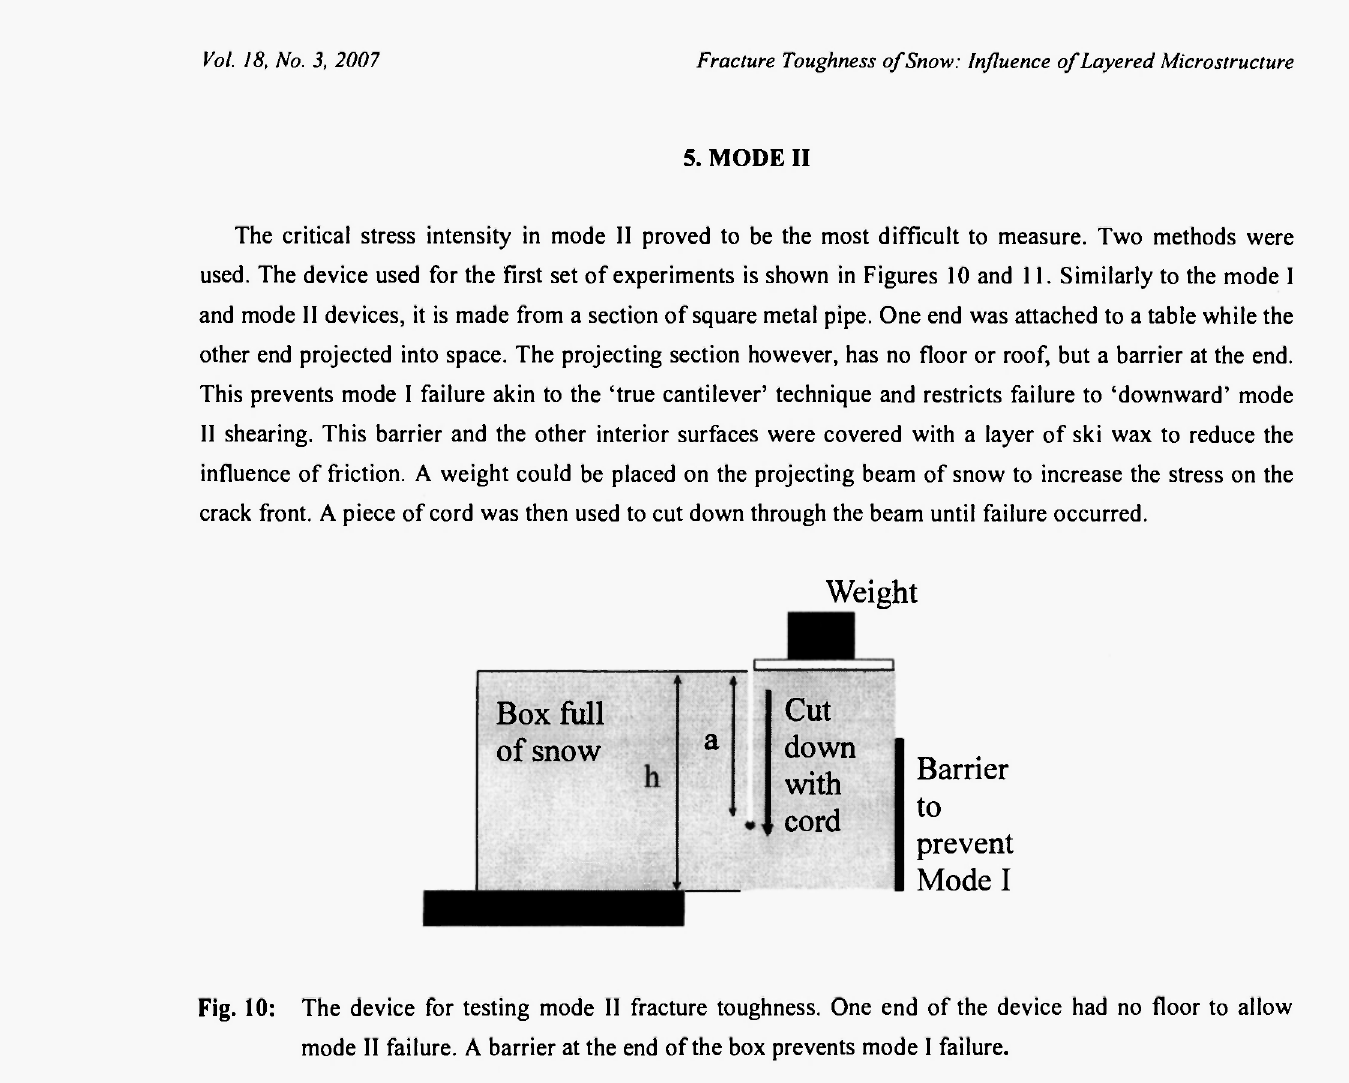
Fig. 10: The device for testing mode II fracture toughness. One end of the device had no floor to allow mode II failure. A barrier at the end of the box prevents mode I failure.